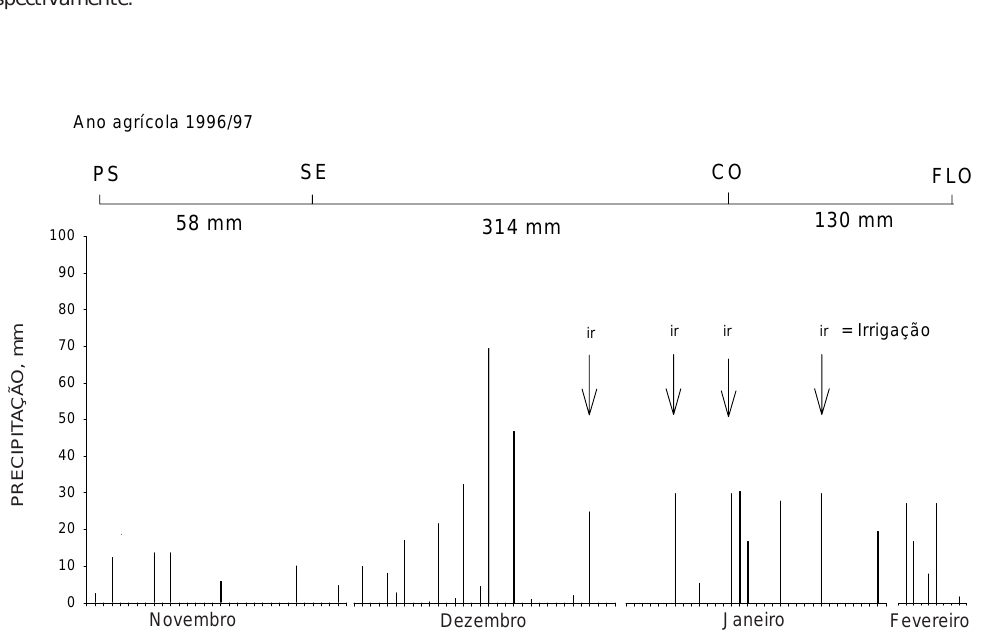
Figura 1. Distribuição das chuvas no período da aplicação do N em pré-semeadura (PS) até o florescimento (FLO) do milho no primeiro